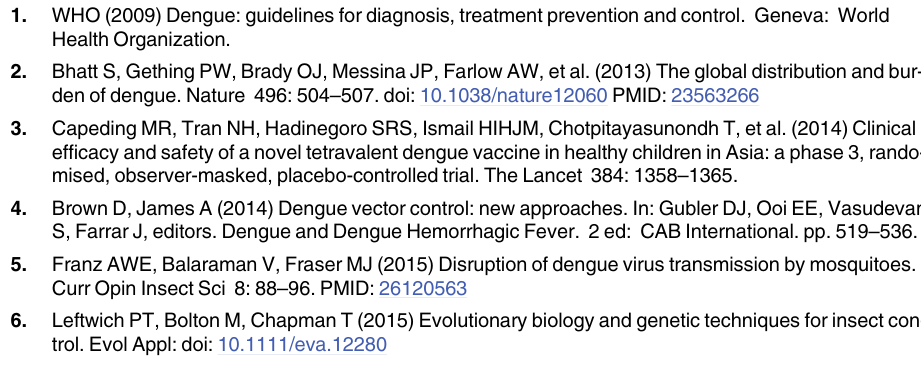
S2 Fig. Comparison of larval survival under starvation conditions between experiments. Larvae of Ae . aegypti were held under starvation conditions in isolation when water was replaced every four days (solid red line) or when water was left unmanipulated (dashed red line). Experiments where larvae were held in groups (grey lines) were conducted under similar conditions (water was replaced), but the mixed cohort (dashed grey line) and recovery (dotted grey line) experiments were conducted at a later time on different generations. Data are aver- aged across all four infection types. Error bars are standard errors. (TIF) S3 Fig. Larval mortality and dead larvae observed when Ae . aegypti larvae were held in groups under starvation conditions. Rates of larval mortality are shown by solid lines while the numbers of dead larvae observed are shown by dotted lines. The dotted line being below the solid line suggests that mortality is occurring at a slower rate than the consumption of lar- vae. (TIF) S4 Fig. Larval mortality of Ae . aegypti and the number of larvae consumed when held in groups under starvation conditions. Rates of larval mortality are shown by solid lines while the numbers of dead larvae inferred to be consumed are shown by dashed lines. The delay between distributions of larval mortality and consumption provide an estimate of the rate of necrophagy in group containers. Mean delays between mortality and consumption are as fol- lows: Uninfected, 0.60 days; w Mel, 0.32 days; w AlbB, 0.44 days; w MelPop, 0.81 days. (TIF) S5 Fig. Pupae and adults of Ae . aegypti observed when larvae were held under starvation conditions in groups of 50. Number of (A) pupae and (B) adults emerging in total from eight containers of 50 larvae for each infection type.